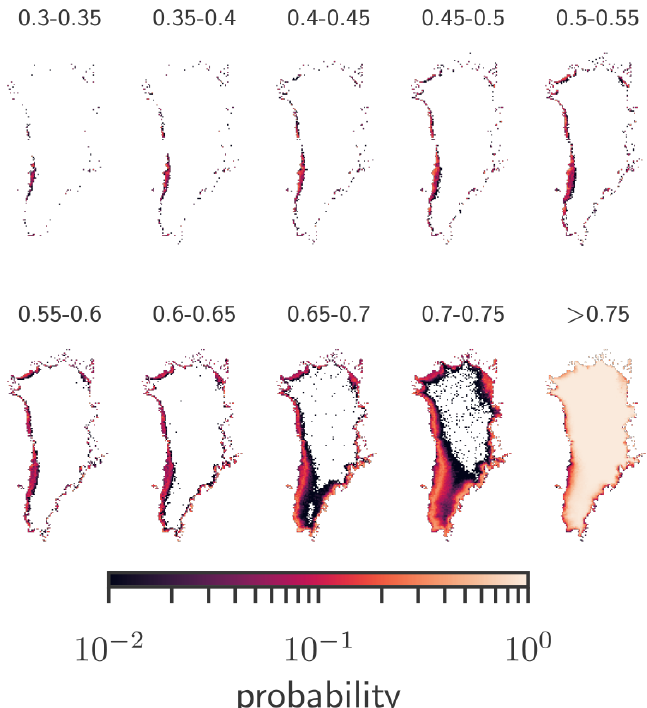
Figure A2. Observed albedo. Local probability to find an albedo value within the given bracket on any day in June, July, or August from 2000–2019. Data: MODIS Greenland albedo; see Box et al.